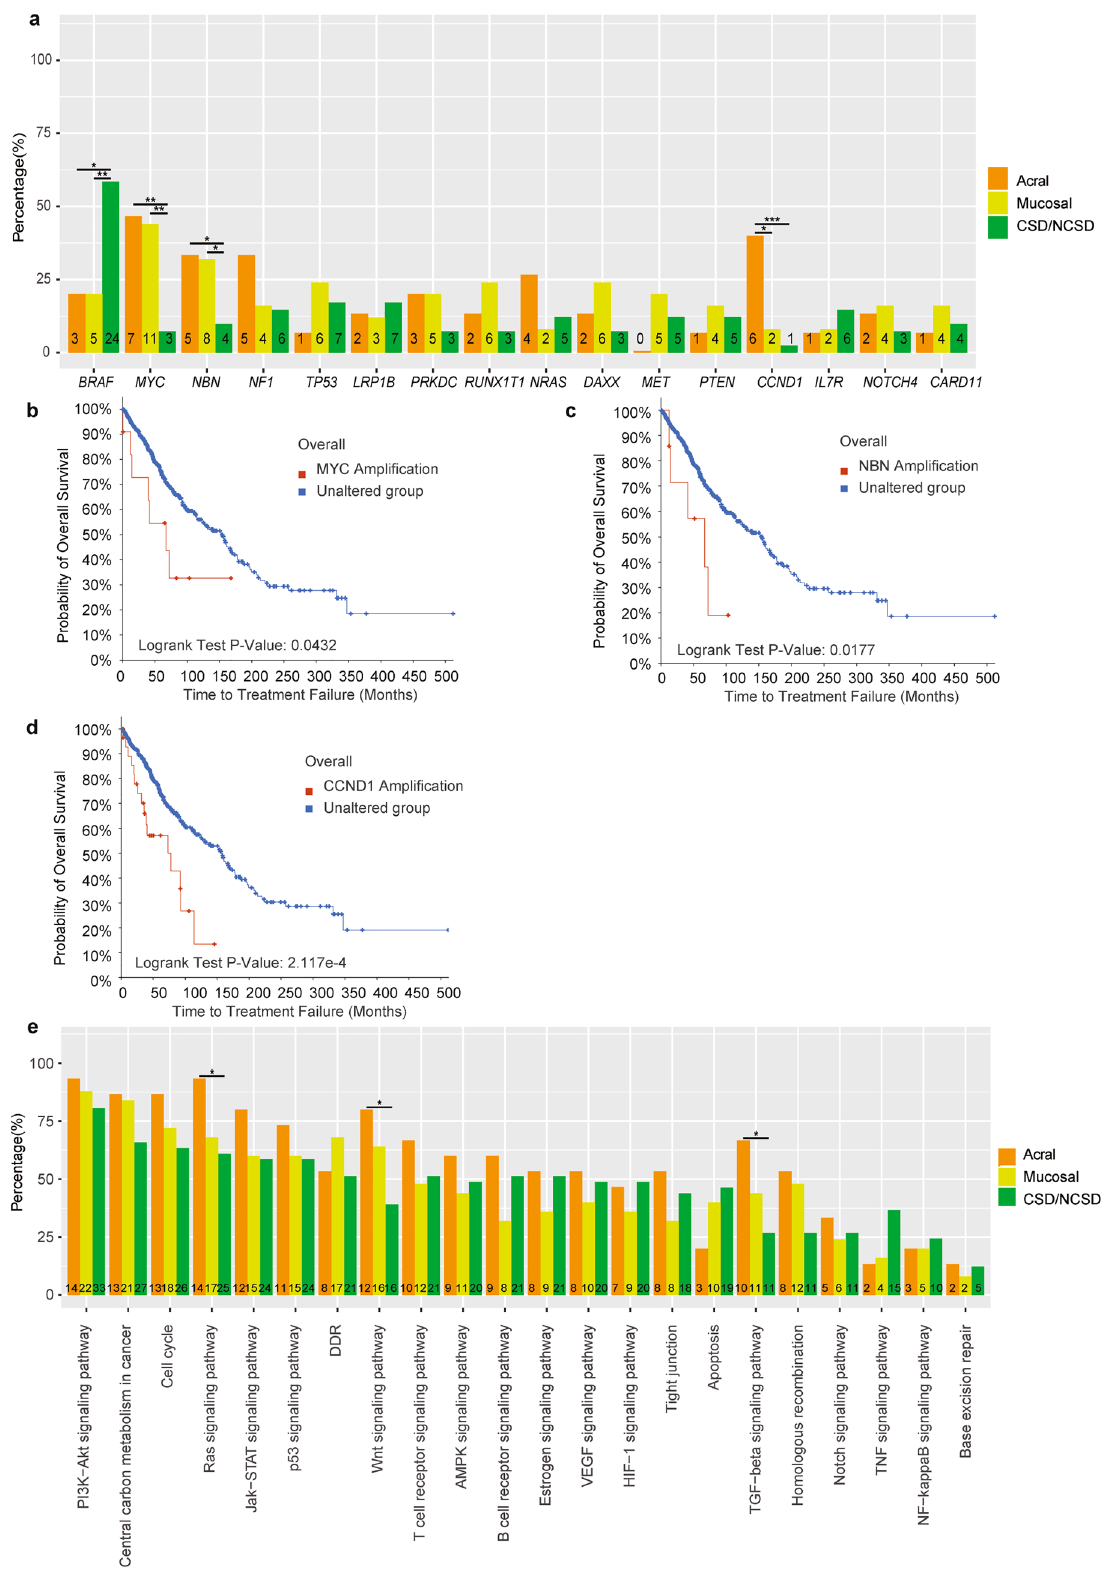
Figure 3. Comparison of variant genes and variant pathways in cutaneous, mucosal and acral melanoma. ( a ) Comparison of variant genes in 3 subtypes (variants that observed over 8 people were showed). ( b – d ) Association of MYC , KDR , and CCND1 amplification with melanoma patient survival in cBioPortal dataset (MSKCC, Clin Cancer Res 2021, n = 696) 14 . ( e ) Comparison of pathway variants, out of which BRAF was excluded due to its highest mutation frequency. Pathway comparison was based on the KEGG Pathway database. Fisher’s exact test was performed, and the statistical significance was defined as * p < 0.05, ** p < 0.01, *** p <